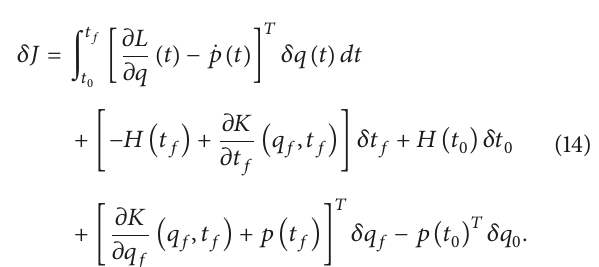
Figure 1: Perturbations of